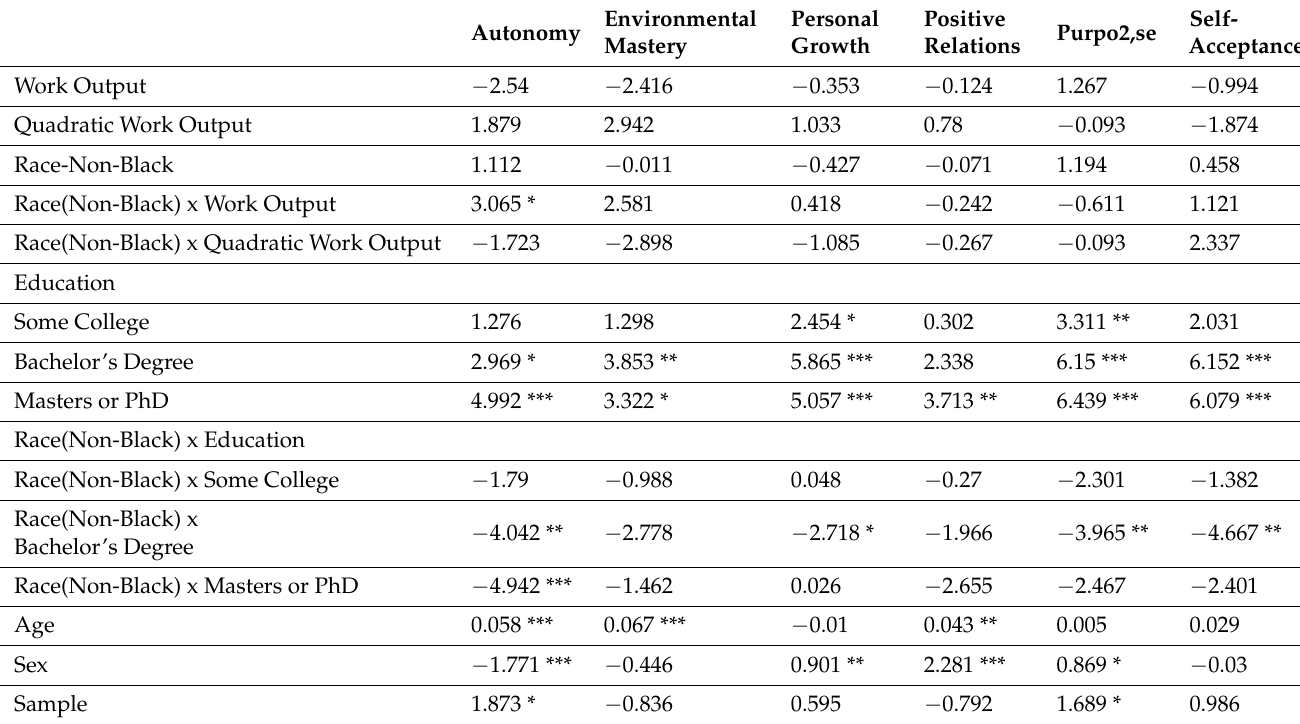
Table A3. Work Output and